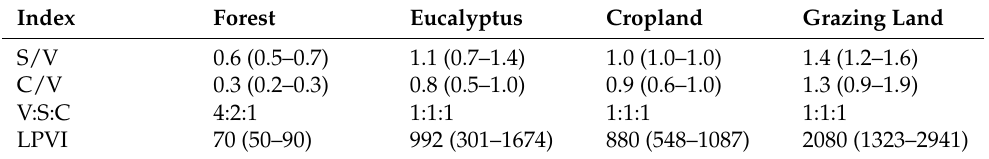
Table 5. Syringyl-to-cinnamyl ratio (S/V), cinnamyl-to-vanillyl ratio (S/V), vanillyl-to-syringyl-to- cinnamyl ratio (V:S:C), and the lignin phenol vegetation index (LPVI) in soil of four land-use systems at Gelawdios, Ethiopia. For S/V and C/V ratios and for the LPVI, mean and range are